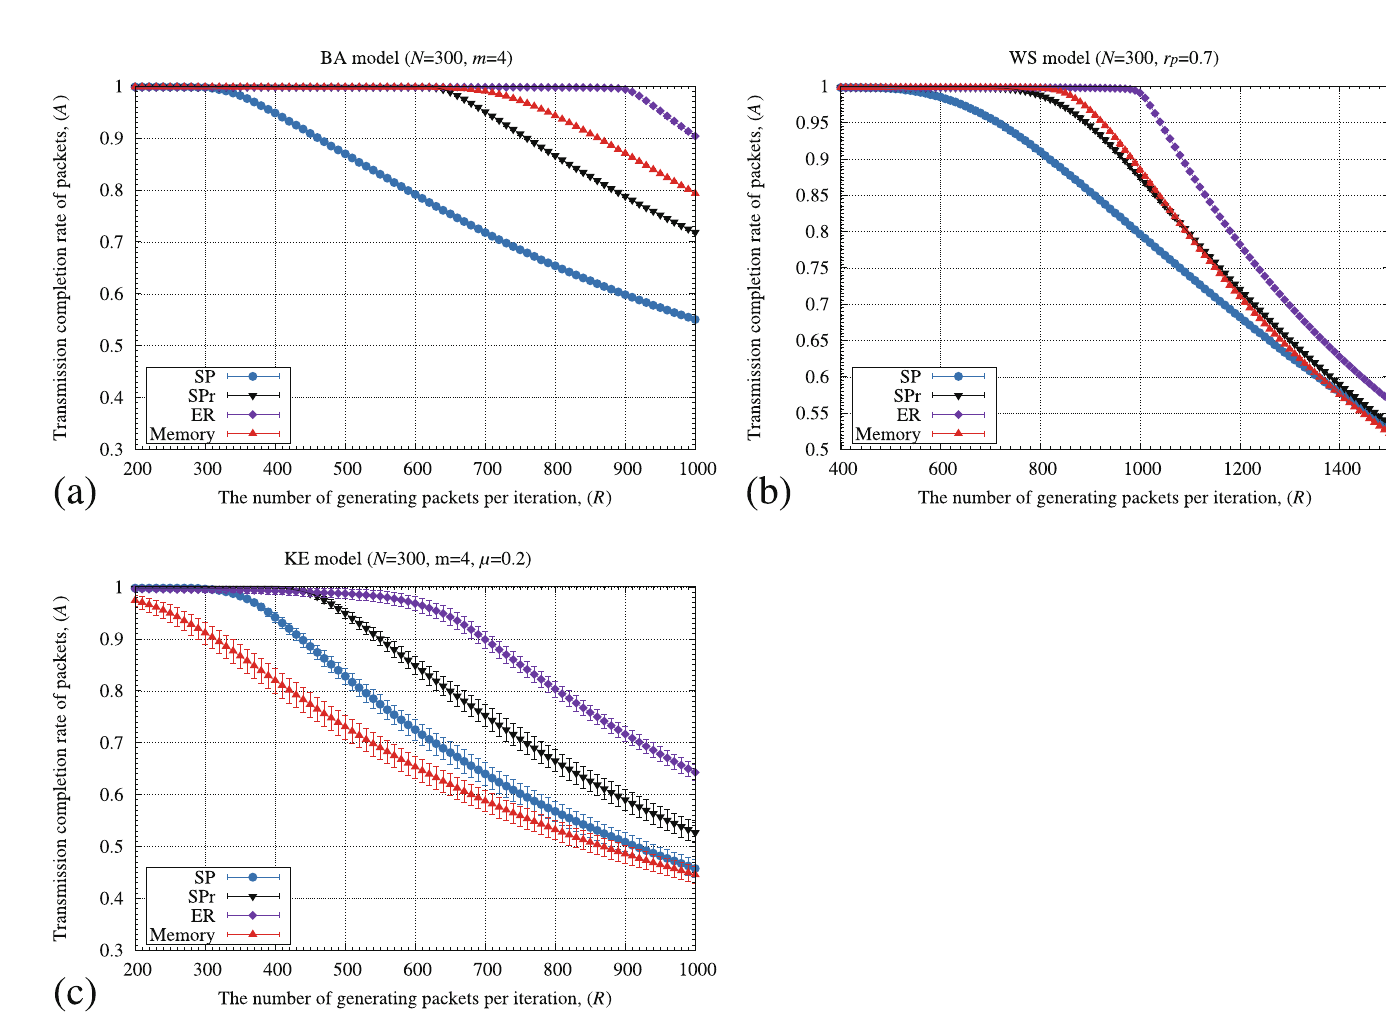
Fig 3. Relationship between the number of generating packets at each iteration ( R ) and transmission completion rate of packets ( A ) by the SP, SPr, ER, and memory methods for the (a) BA, (b) WS, and (c) KE models. In these figures, the standard deviation of each method is plotted as error bars.